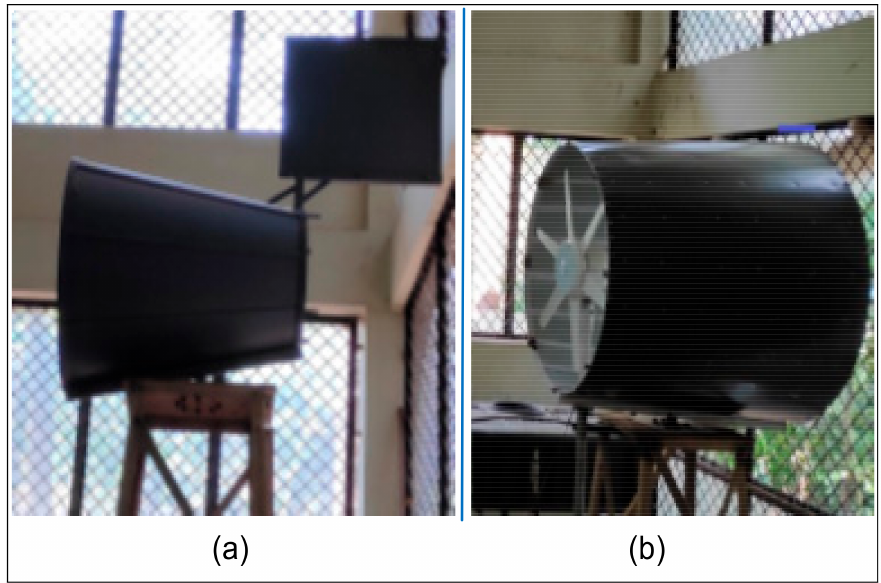
Figure 12. ( a ) Concentrator and ( b ) diffuser, mounted for